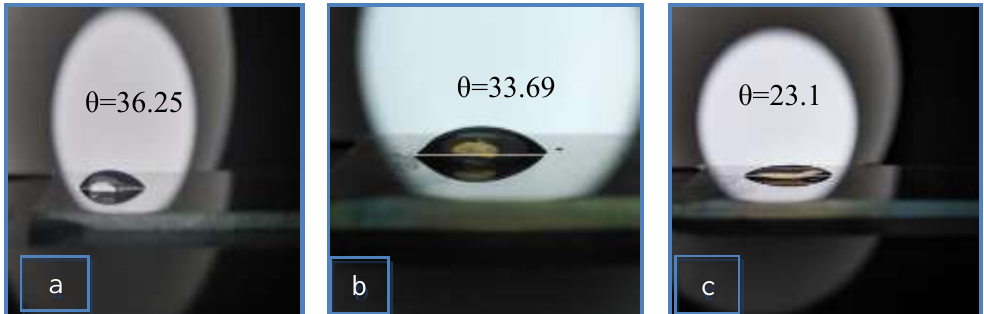
Fig.10a: Images of water droplet on the sample pure TiO b- after15 min. of Uv irradiation c- an hour UV irradiation.